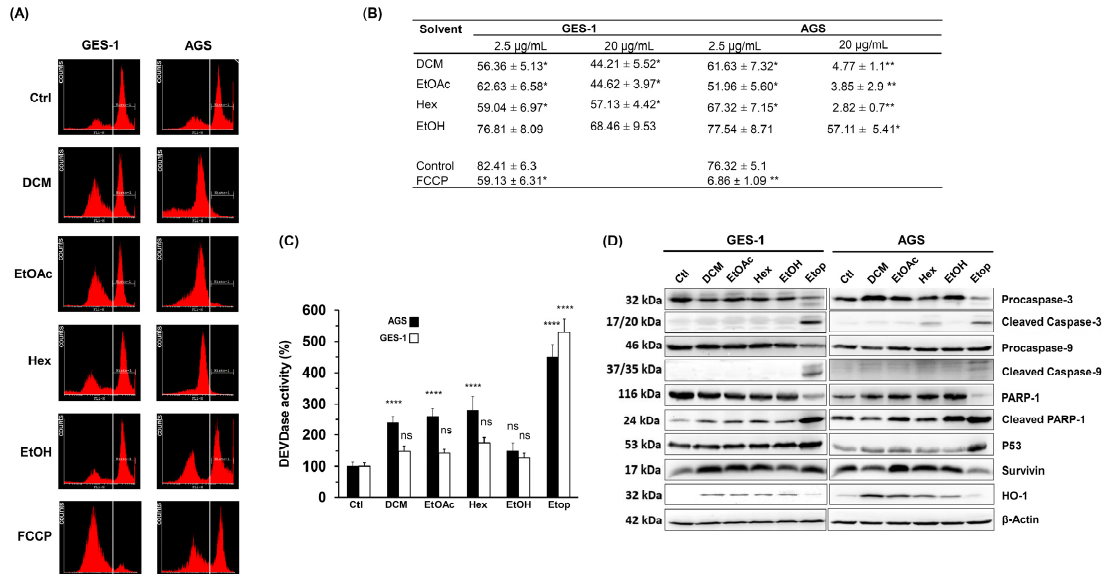
Figure 2. L. rivularis flower extracts trigger loss of mitochondrial membrane potential and apoptosis in gastric cancer cells. ( A ) GES-1 and AGS cells were treated with the extracts (DCM, EtOAc, Hex, or EtOH) at 20 µ g/mL or FCCP 1 µ M for 24 h. The cells were then stained with Rhodamine 123 and analyzed by flow cytometry. Representative histograms are shown. The vertical white line separates Rhodamine-positive (right side) and Rhodamine-negative (left side) cell populations. ( B ) GES-1 and AGS were treated with L. rivularis flower extracts at concentrations of 2.5 µ g/mL and 20 µ g/mL. The percentage of Rhodamine-positive cells is shown (means ± S.D., n = 3; * p < 0.05, and ** p < 0.01). ( C , D ) GES-1 and AGS cells were treated with DCM 5 µ g/mL, EtOAc 5 µ g/mL, Hex 10 µ g/mL, EtOH 15 µ g/mL, or Etoposide 50 µ M for 24 h. ( C ) DEVDase activity was evaluated in total cell lysates. Bars represent the percentage of DEVDase activity compared to the control condition (means ± S.D., n = 3, **** p ≤ 0.0001, ns: non-significant). ( D ) Changes in the protein levels of